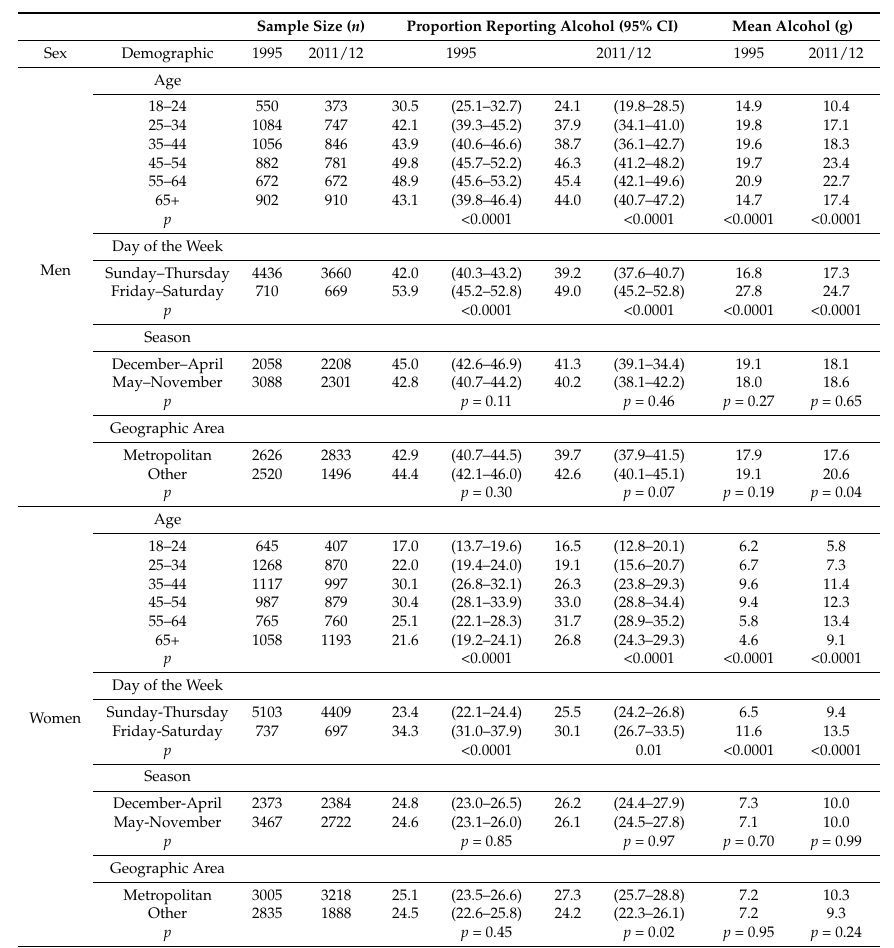
Table 1. Effects of age, geographic location, day-of-the week, and season on the proportion of consumers and per-capita intake of pure alcohol for Australian adults aged 18 years and over stratified by sex and survey, for participants of the National Nutrition Survey 1995 and National Nutrition and Physical Activity Survey, 2011/12. p < 0.001 considered significant: Pearson’s Chi-square test for differences in proportions, ANOVA or Student’s t -test for mean